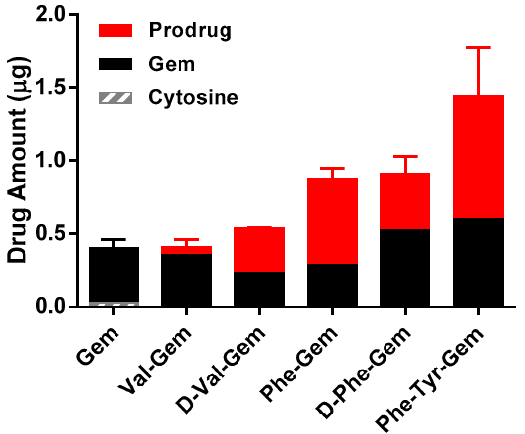
Figure 2. Uptake study of Gem and Gem prodrugs in HFF cells (Mean ± S.D., n = 4).